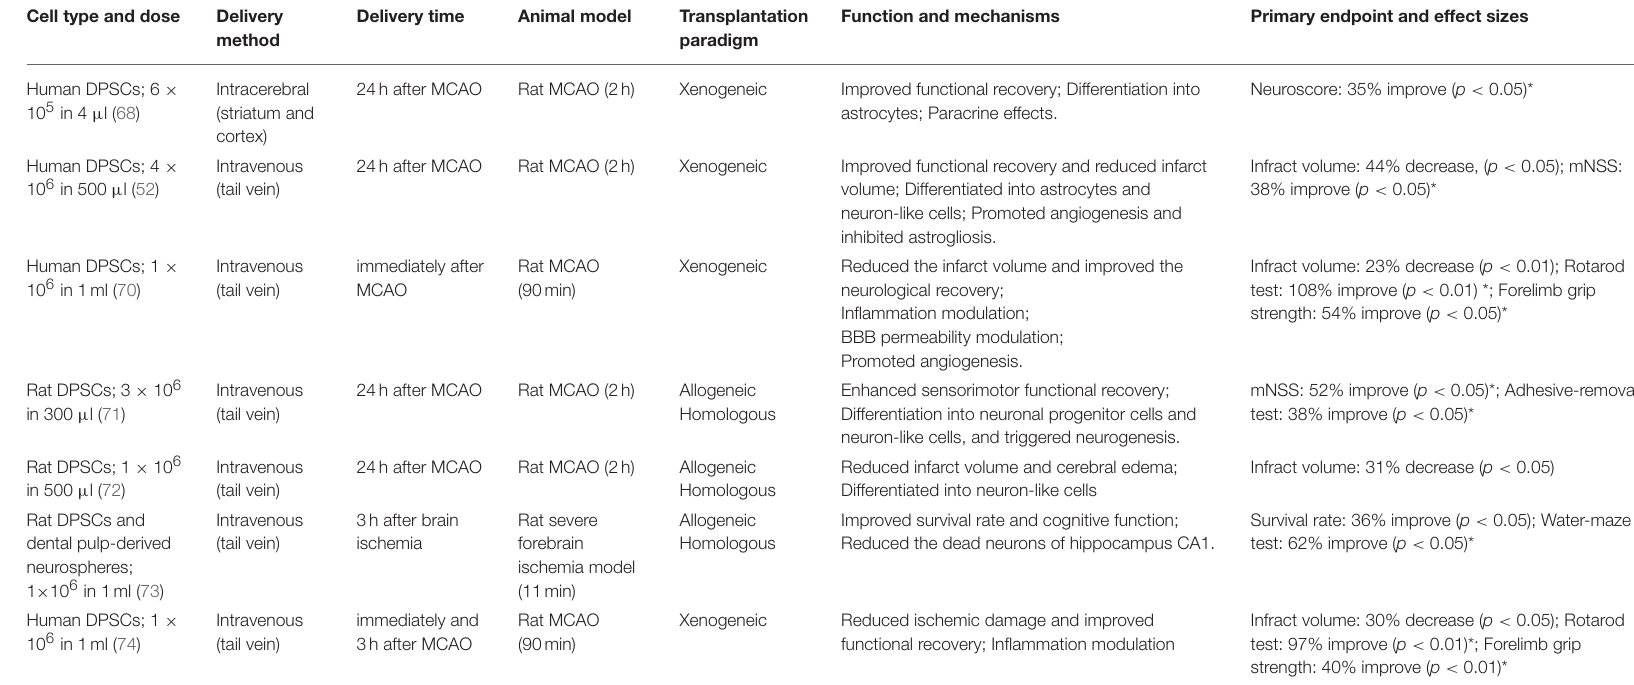
TABLE 3 | Overview of DPSCs therapy for ischemic stroke animal